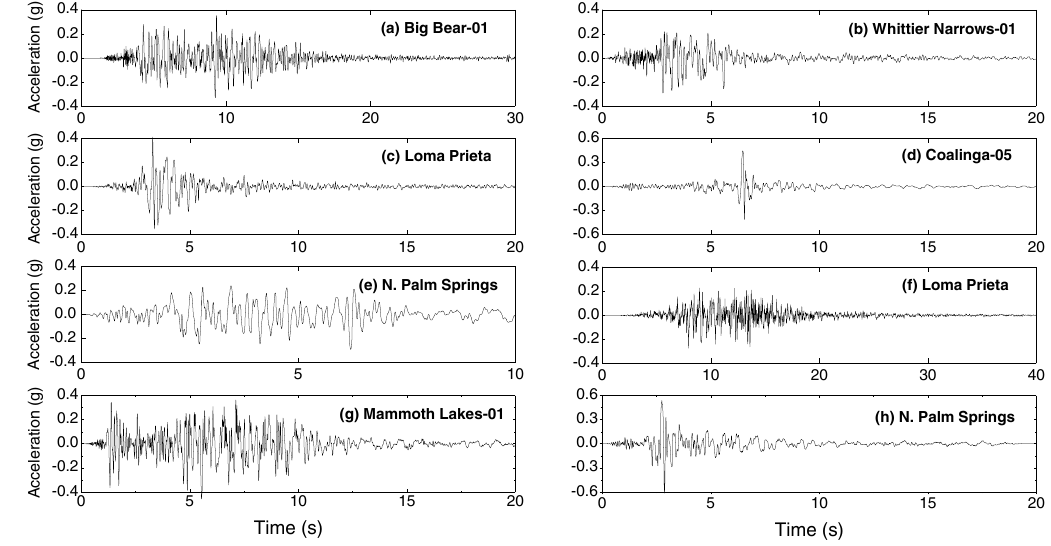
Figure 10. Eight time history recommendations for Kaohsiung (site b) with DSHA calculations and the NGA strong-motion database.